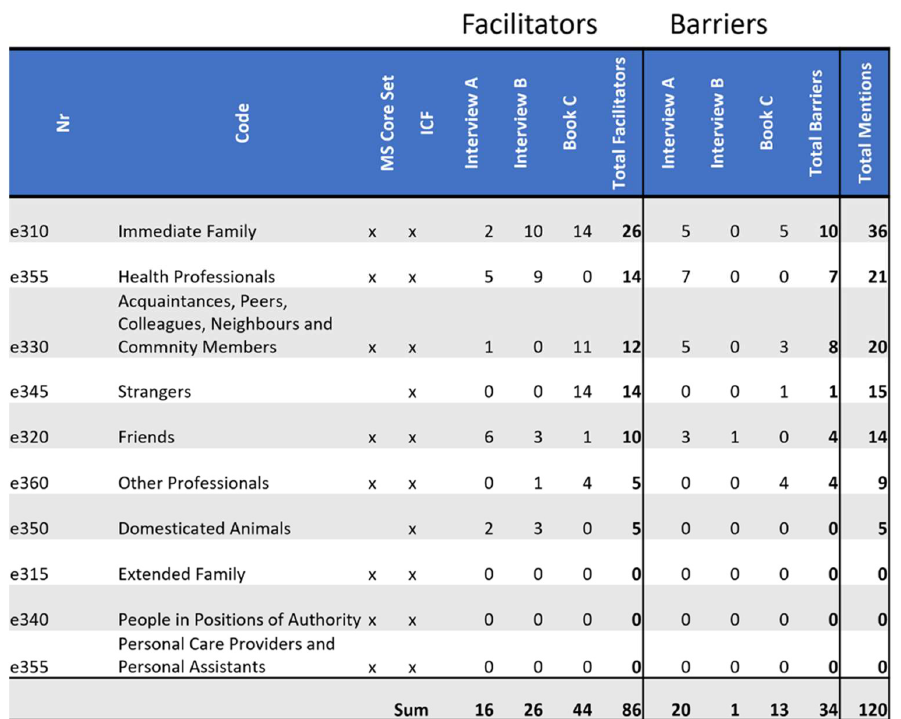
Figure 6. Distribution of codes in the domain e3 Support and Relationships : This figure shows the frequency of MS core set codes and non-core set codes of this domain referenced in each source as a facilitator and as a barrier. Additionally, it tallies all references throughout the domain as facilitators or as barriers by source, as well as tallying facilitators and barriers separately and together by code.